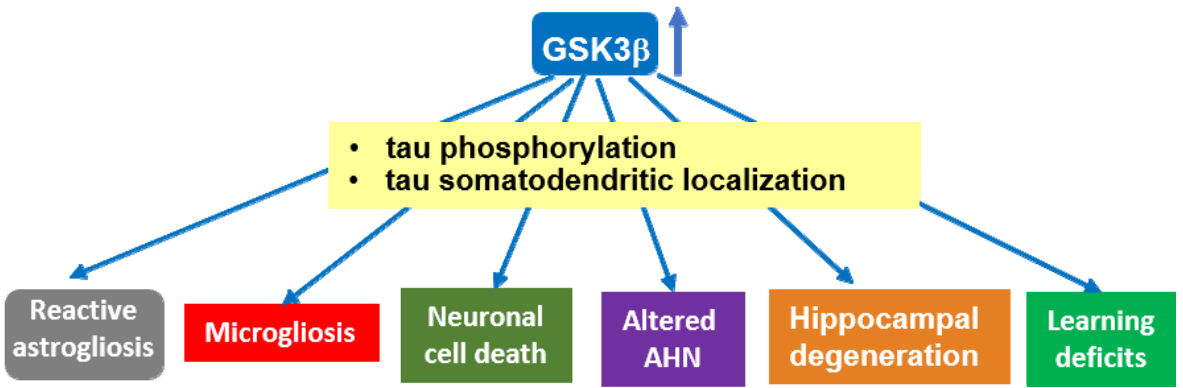
Figure 1. Overexpression of GSK-3 β induces tau-dependent AD-like pathology. Transgenic mice overexpressing GSK-3 β (Tet/GSK-3 β mice) in forebrain show tau hyperphosphorylation and relocalization to the somatodendritic compartment in hippocampal neurons, in correlation with different signs of neurodegeneration. These mice recapitulate different aspects of AD pathology, which—at least partially—rely on GSK-3 β -induced hyperphosphorylation of tau protein. A similar role for GSK-3 α in tau hyperphosphorylation found in AD cannot be precluded, as it has not been extensively analyzed. Abbrev: AHN: Adult hippocampal